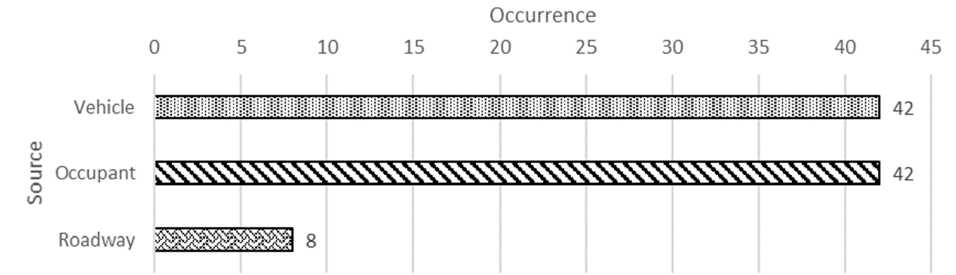
Figure 2. Three sources of desired information that the interviewed emergency medical services (EMS) personnel mentioned when addressing what information they wanted to have in order to improve the effectiveness and efficiency of vehicle collisions response.